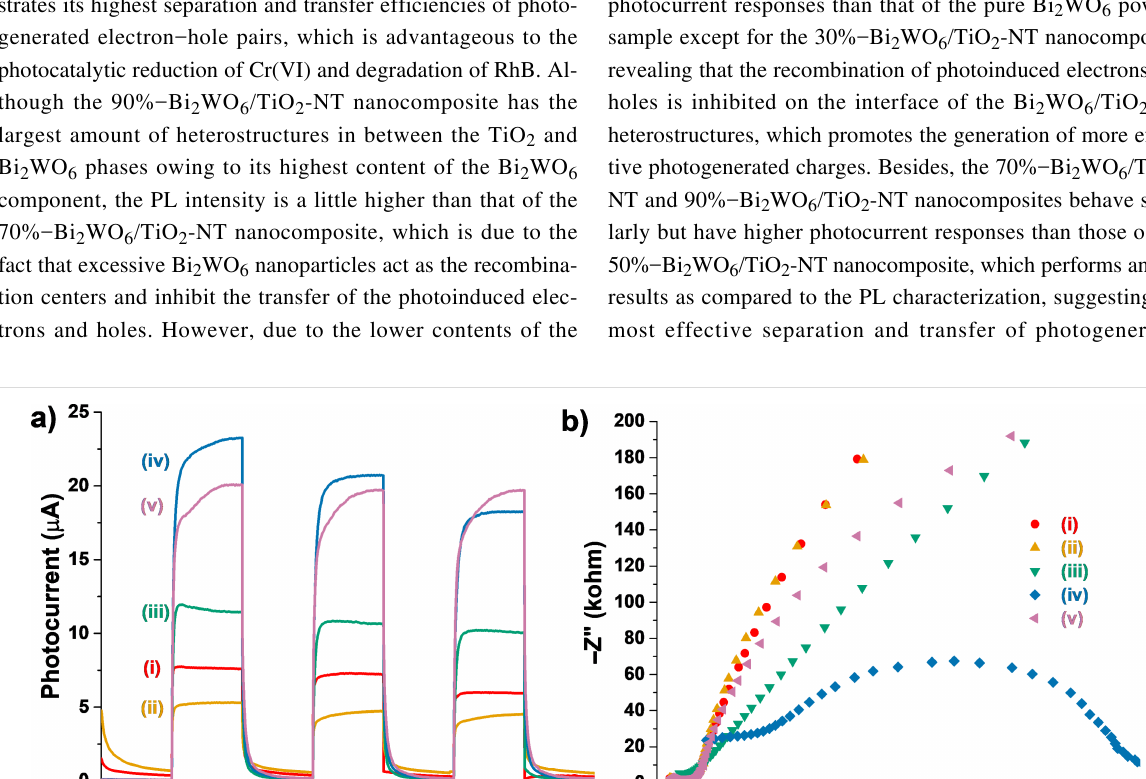
conduction bands in between TiO 2 and Bi 2 WO 6 phases in the Bi 2 WO 6 /TiO 2 -NT nanocomposites results in the aforemen- tioned enhancement